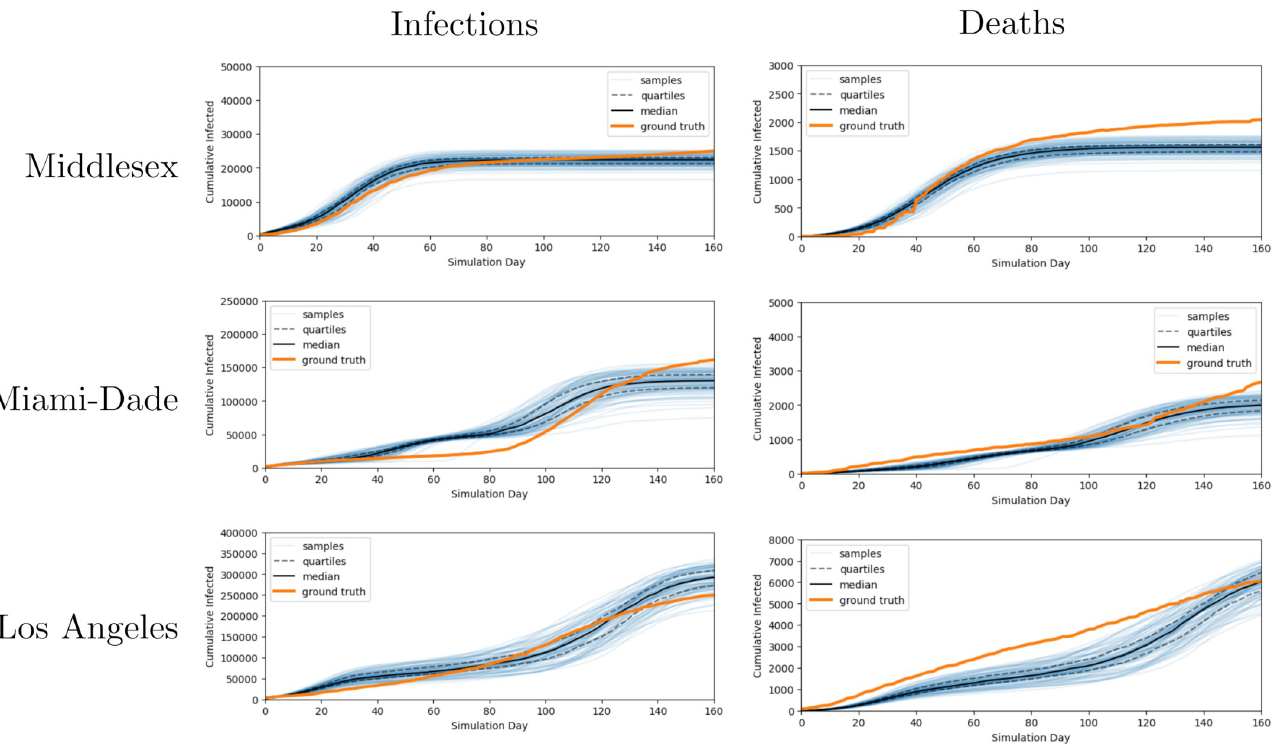
Fig 16. Cumulative infection trajectories sampled from model fit to infection and death data. We see that posterior samples of cumulative infection and death counts from several counties are generally in good agreement with the data when we use both infections and deaths as input observations to our model.